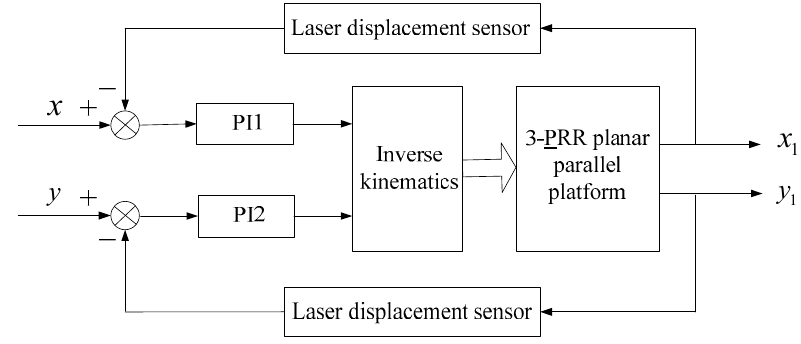
Figure 11. PI control of the 3-PRR parallel platform.